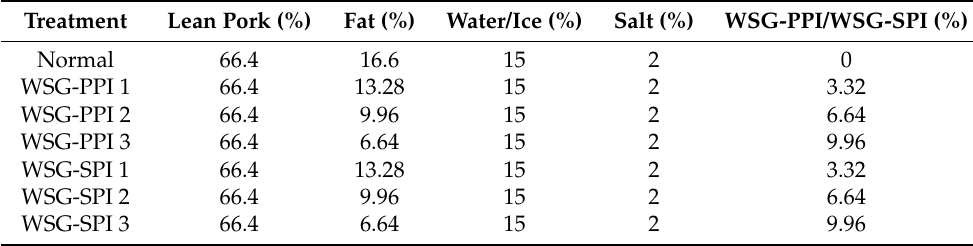
Table 1. Formulations of